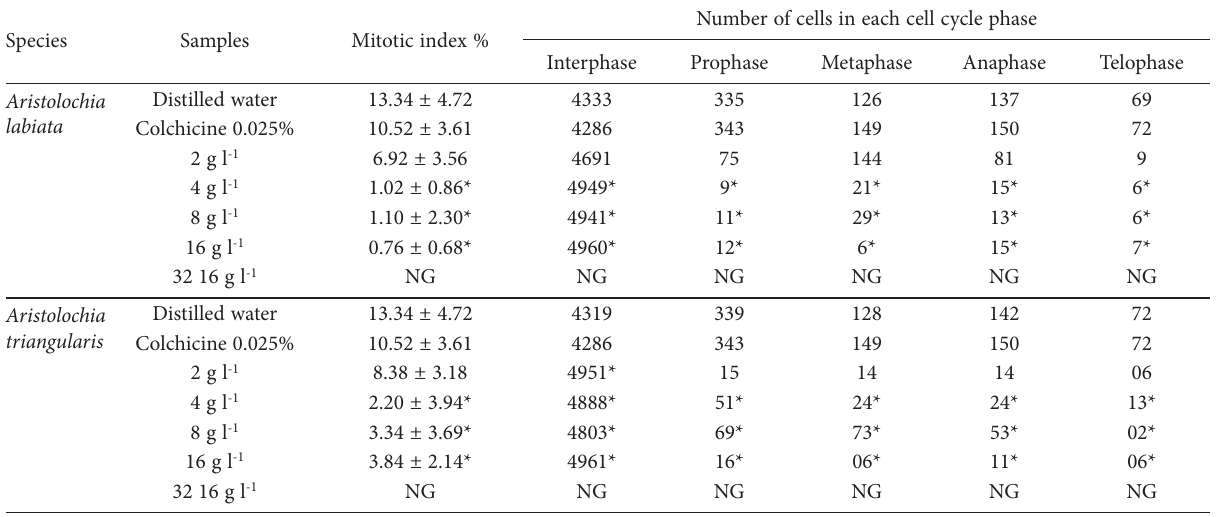
Table 3. Mitotic index (% percentage ± standard deviation) of Allium cepa root meristem cells exposed to decoctions of Aristolochia labiata and Aristolochia triangularis